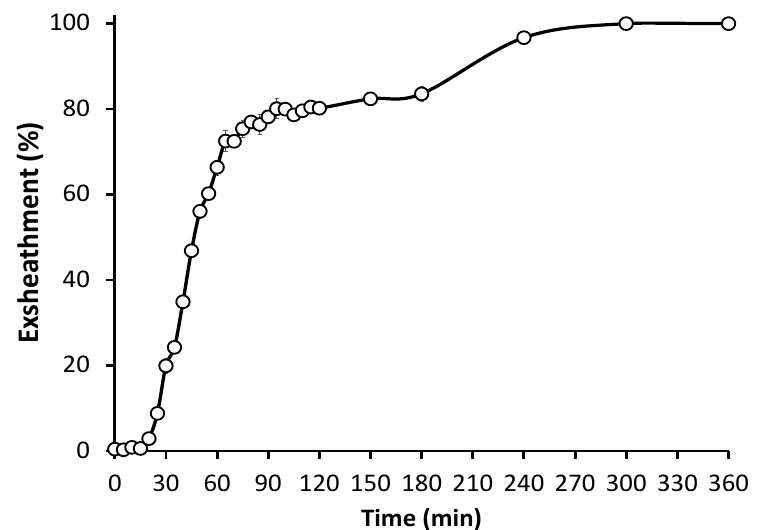
Figure 3. H. contortus infective larvae during in vitro exsheathment. Time series analysis of the exsheathment activity of H. contortus L3 using the anaerobic in vitro system. Mean of the total exsheathment percentage (±SEM) at each time point across replicates ( n = 5). Significant ( p < 0.001) exsheathment was obtained resulting in 75% and 100% of larvae exsheathing after 70 min and 5 h, respectively, post trigger exposure. No exsheathment activity was observed in the absence of anaer- obic treatment conditions. Exsheathment up to 6 h post trigger application shown. The SEM imaging was able to capture the physiological changes and provide a de- Cells 2022 , 11 , x FOR PEER REVIEW tailed insight into the anatomy of the H. contortus third-stage larvae that occurs during exsheathment, a crucial step determining infection as the larvae transition from infective to parasitic developmental stages. The first indication of ecdysis and initiation of cuticle digestion occurred after only 2 min incubation, and was characterized by an indentation at the anterior termination of the lateral alae (Figure 4). The cuticle region both anterior and posterior to this point swelled, and then depressed to form the refractile ring region. Along the circumference of the refractile ring region, the indentation gradually deepened until holes began to appear in the cuticle, and the release of the exsheathment fluid could first be observed at the 4 min time point. The cuticle hole increased in size to form a con- tinuous separation along the annulus ( t = 7 min), and at the 9 min time point the first examples of the cuticular cap being forced off by the head of the L3 was observed. As the L3 escaped through the opening, the posterior portion of the cuticle generally separated along the lateral alae, leaving the cap attached to the remainder of the cuticle. Notably and in agreement with early microscopic descriptions of the ecdysis process in other species of parasitic nematodes, no pores or other openings were visible on the body of the exsheathed xL3 in the region where the refractile ring had initially formed. In prospective, our results call for further investigation of the application of our in vitro system to activate a succession of events that begin with triggering exsheathment and the subsequent devel- opment to the fourth stage in additional species of parasitic nematodes infecting a variety of hosts.